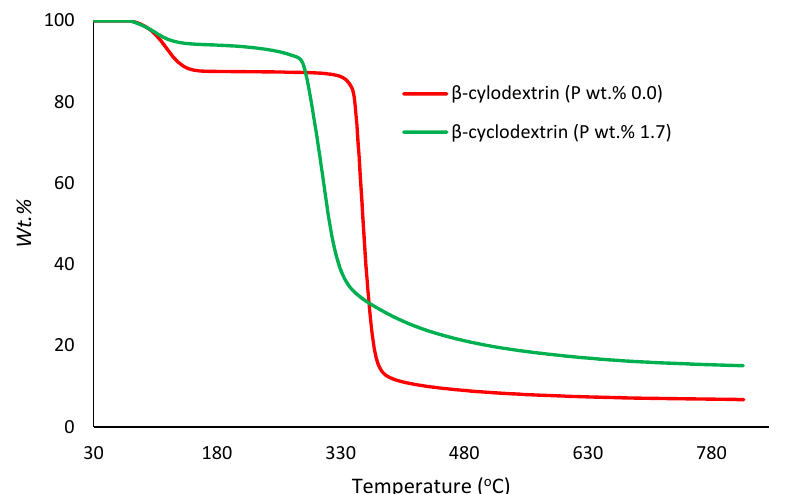
Figure 3. Thermograms of modified and unmodified versions of β -cyclodextrin at 60 °C/min.